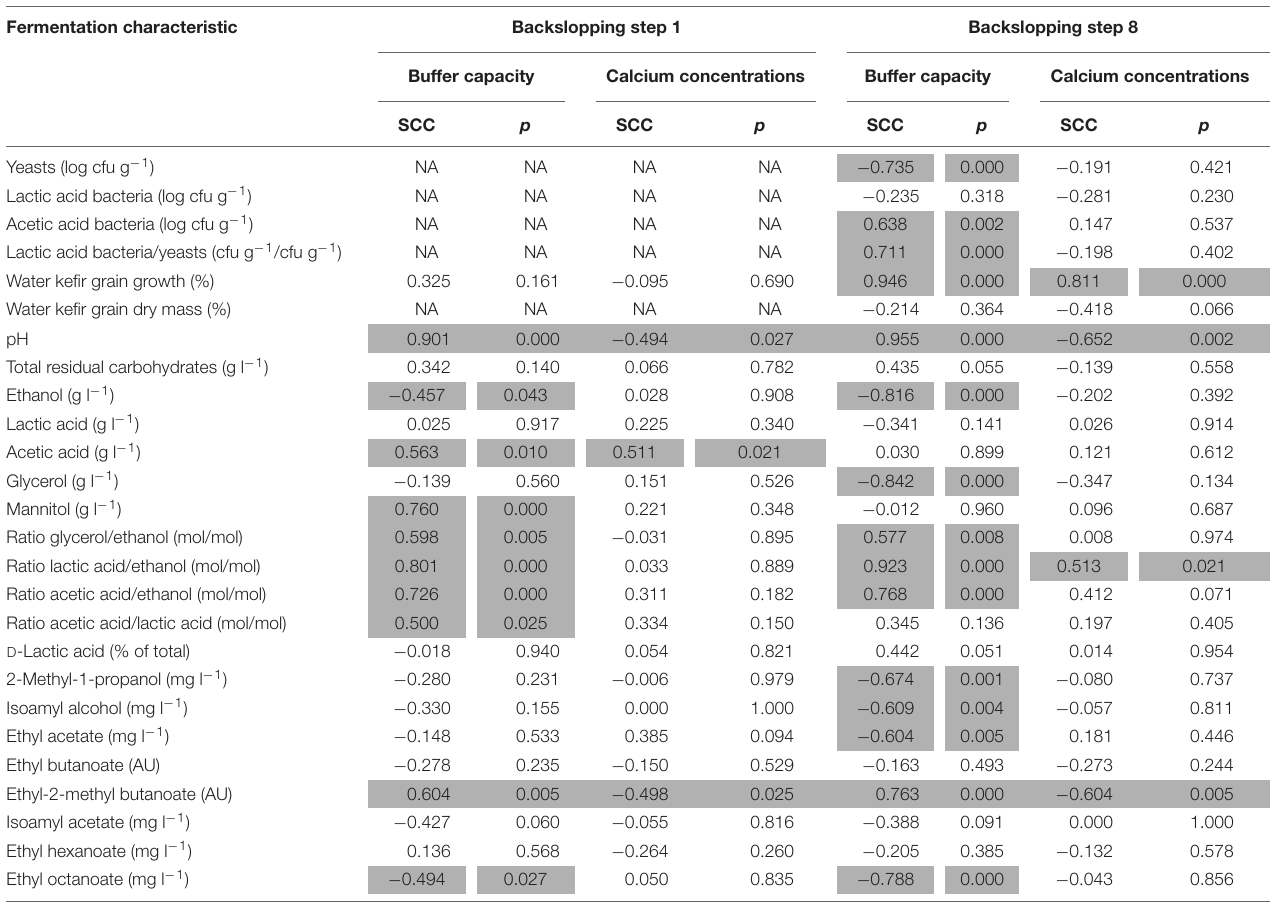
TABLE 2 | Spearman correlation coefficients (SCCs) between the buffer capacity (controlled for the calcium concentration) or the calcium concentration (controlled for the buffer capacity) of the water used for fermentation and the characteristics of the eight water kefir fermentation series examined (differing in the buffer capacity and calcium concentration of the water used for fermentation), at the end of backslopping steps 1 and